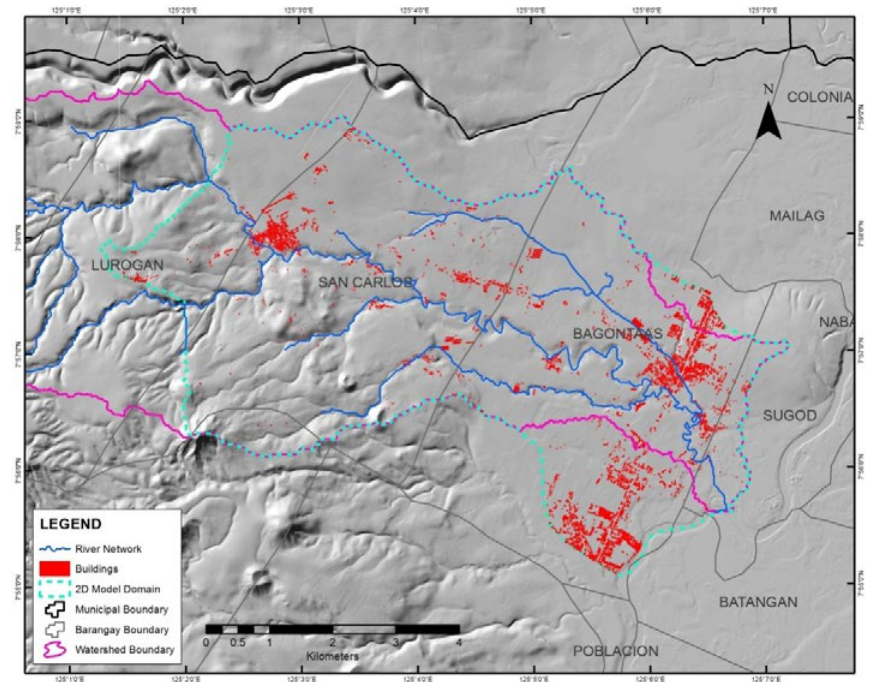
Fig. 4: Extracted building features within the 2d model domain of Malingon river basin